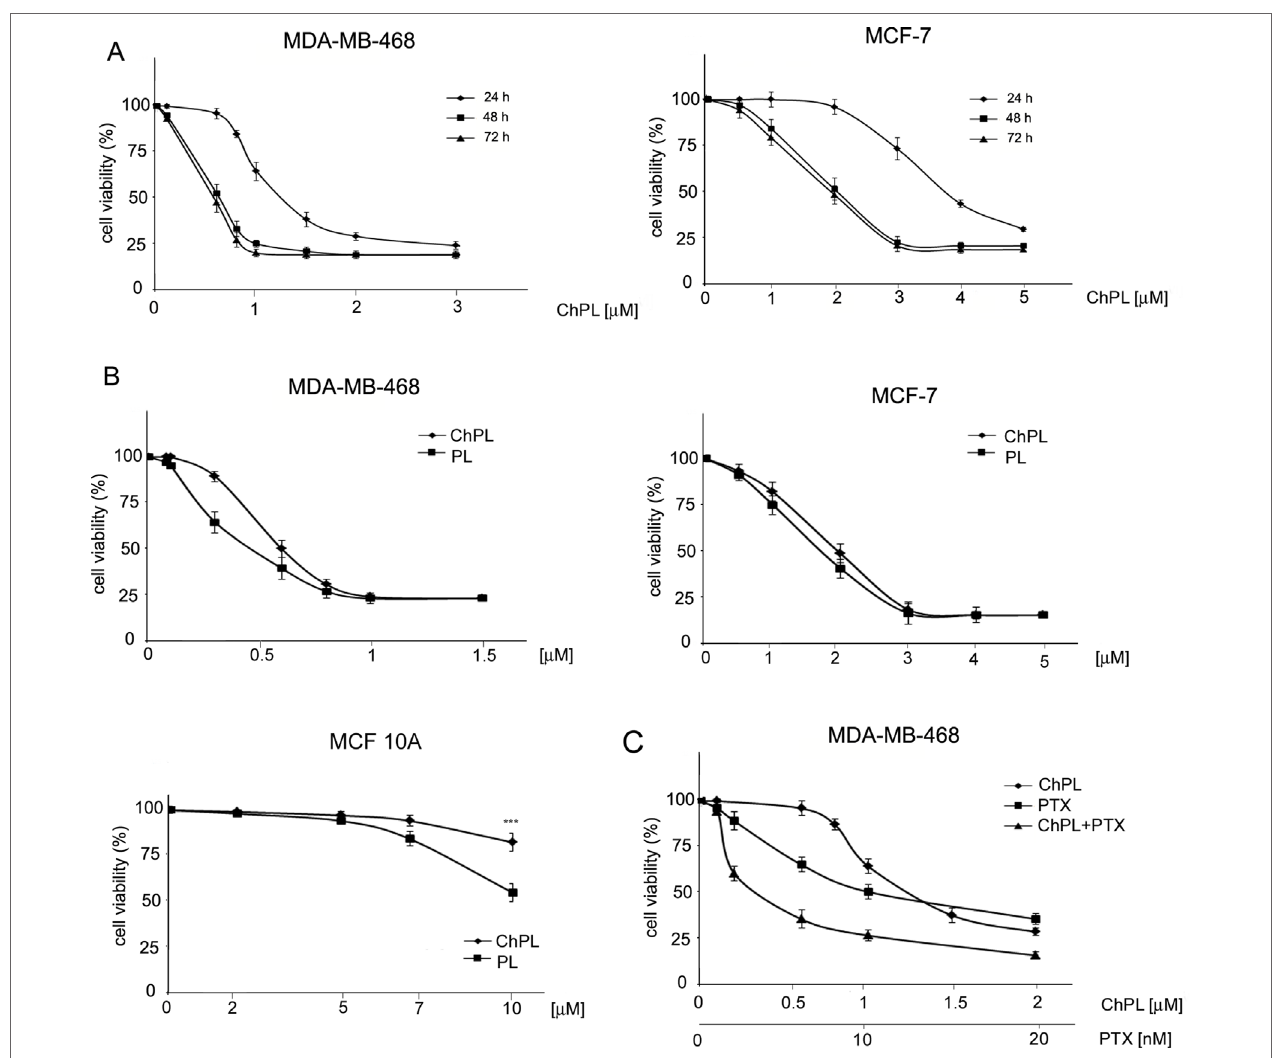
FIGURE 1 | Effects of 3-chloroplumbagin (ChPL) and plumbagin (PL) on the viability of MDA-MB-468 and MCF-7 breast cancer cells and breast epithelial cells, MCF10A (A) Dose-dependent effects of ChPL on the reduction in cell viability. Cell survival was assessed with the MTT assay, n = 3. (B) Comparison in activity between ChPL and PL. Cell survival was assessed with the MTT assay, n = 3. Data were analyzed by one-way ANOVA with Tukey’s post hoc tests [ p < 0.001 (***)]. (C) Combined effects of ChPL and paclitaxel (PTX) on the viability of MDA-MB-468 cells. Cell survival was assessed with the MTT assay, n =